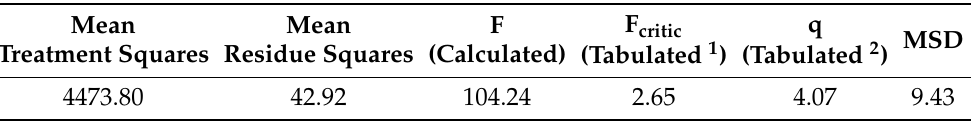
Table 5. ANOVA and Tukey’s test parameters for composites’ flexural